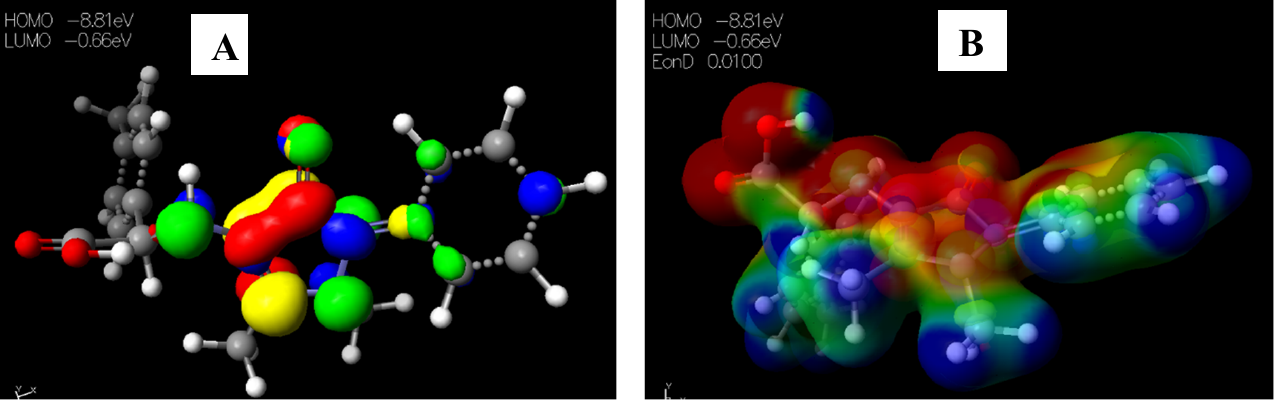
Figure 10. Images showing the ( A ) Highest occupied molecular orbital (HOMO) and Lowest unoc- cupied molecular orbital (LUMO) and ( B ) Molecular electrostatic potential (MESP) plots of 6.